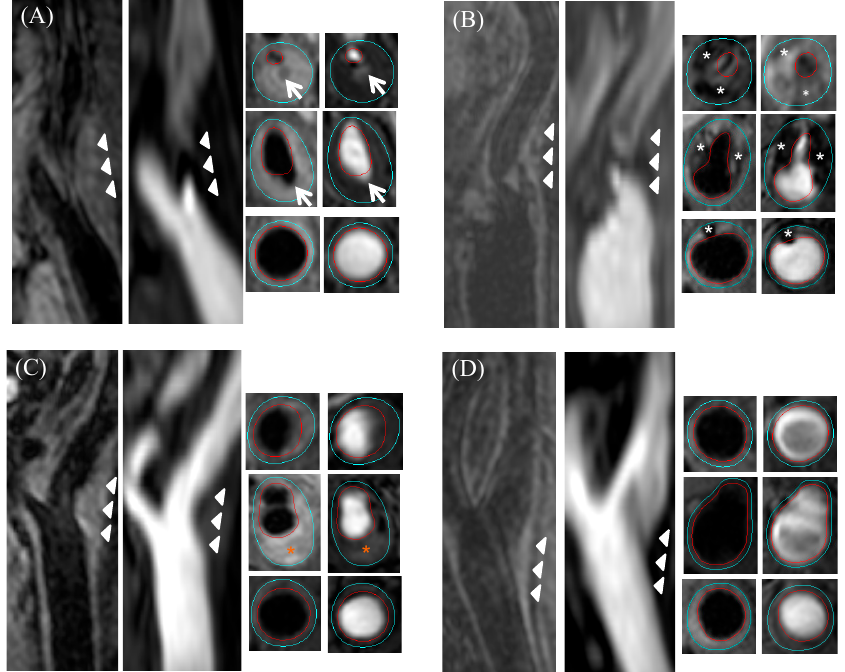
Figure 1. Example magnetic resonance images of the four groups. ( A ) SS(+)/HRP(+): significant stenosis with ulceration (white arrow); ( B ) SS(+)/HRP( − ): significant stenosis with calcified plaque (white asterisk); ( C ) SS( − )/HRP(+): no significant stenosis with IPH (orange asterisk); ( D ) SS( − )/HRP ( − ): no significant stenosis with small plaque. Red outline, lumen; light blue outline, outer vessel wall; white arrowheads, outer vessel wall. (SS = significant stenosis, HRP = high-risk plague, IPH = intraplaque hemorrhage).